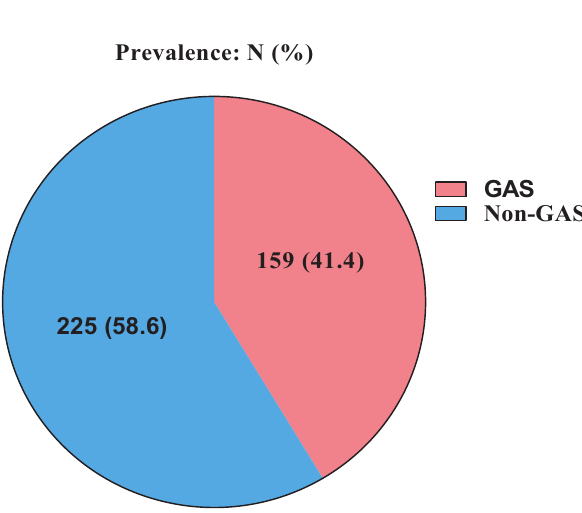
Figure 2 : Overall prevalence of streptococcal sore throat. GAS, Group A streptococci; Non-GAS, Non-group A streptococci; N, Number.